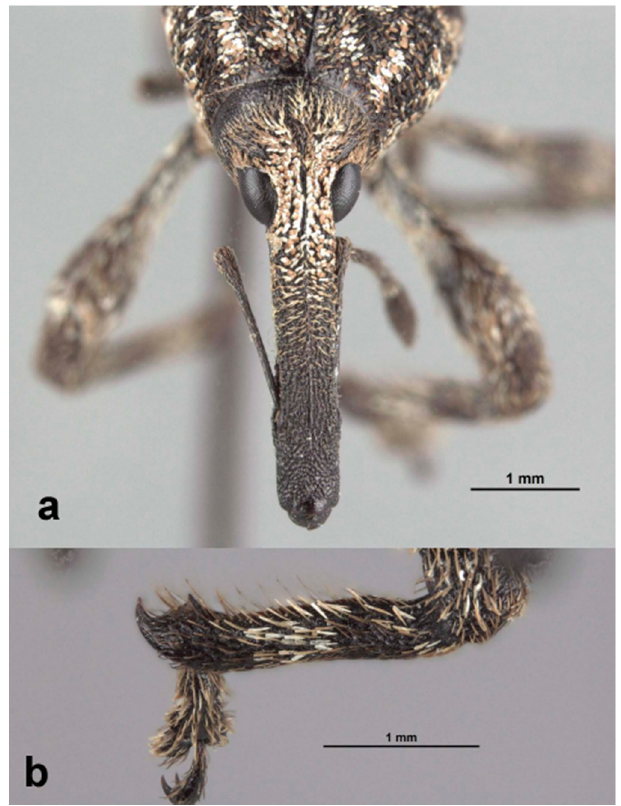
Figure 11. Ilacuris suttoni : ( a ) rostrum of male, dorsal aspect; ( b ) protibia of male, anterior aspect. 3.2.4. Kuschelorhinus Anderson & Setliff, New Genus Type species: Kuschelorhinus hirsutus Anderson & Setliff, new species.